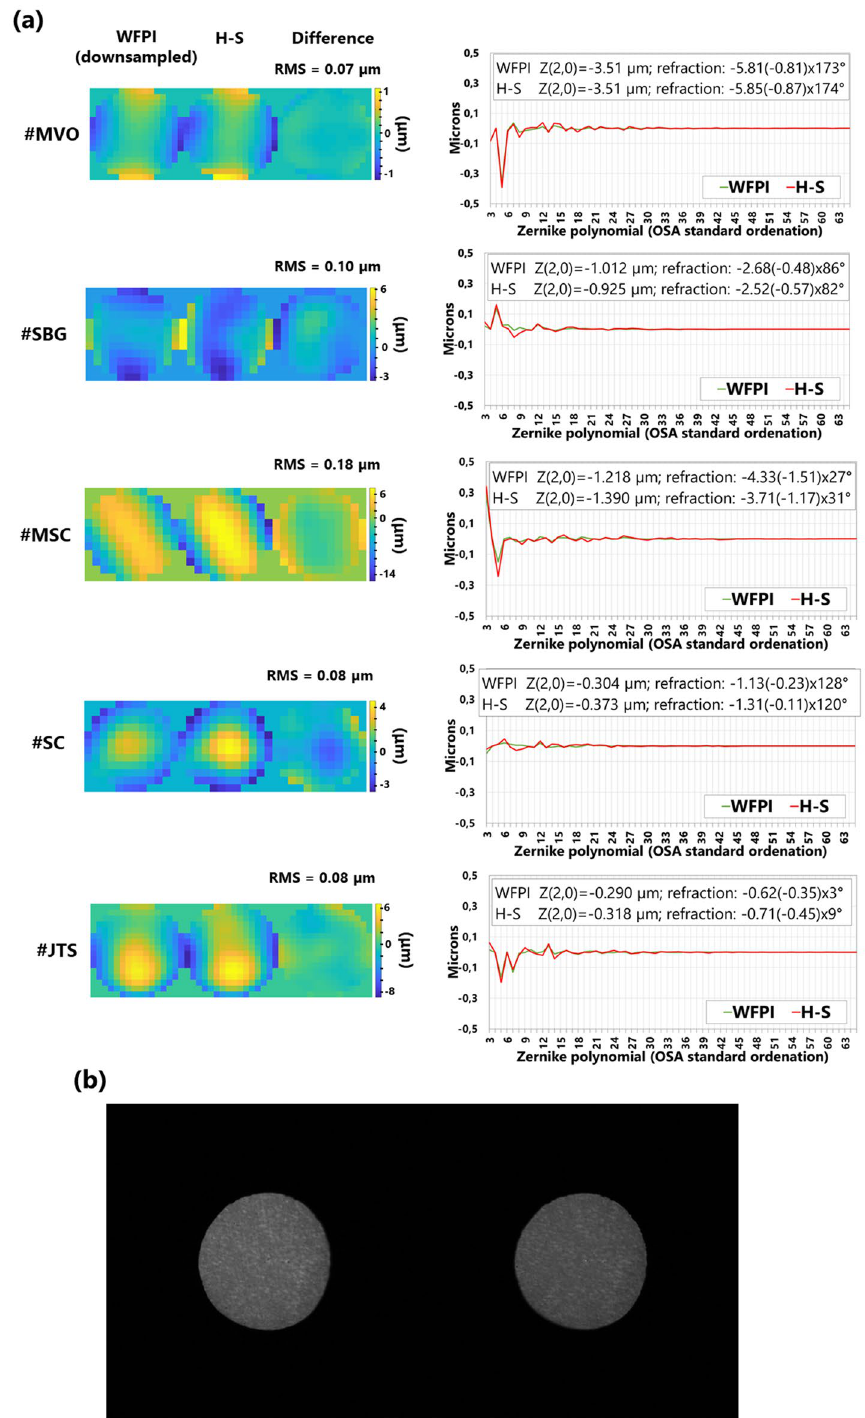
Figure 5. Measurements of 5 real eyes with the device. (a) Recovered phase map with the WFPI and with the H–S as well as its difference map together with its RMS value. On the right, the comparison of Zernike polynomials can be seen. For clarity, the defocus value (Zernike 4) is set to zero on the graph, and the numerical value is provided, along with the sphero-cylindrical refraction, in the upper box of each individual graph. (b) Example of intensity images captured with the WFPI sensor, corresponding to eye